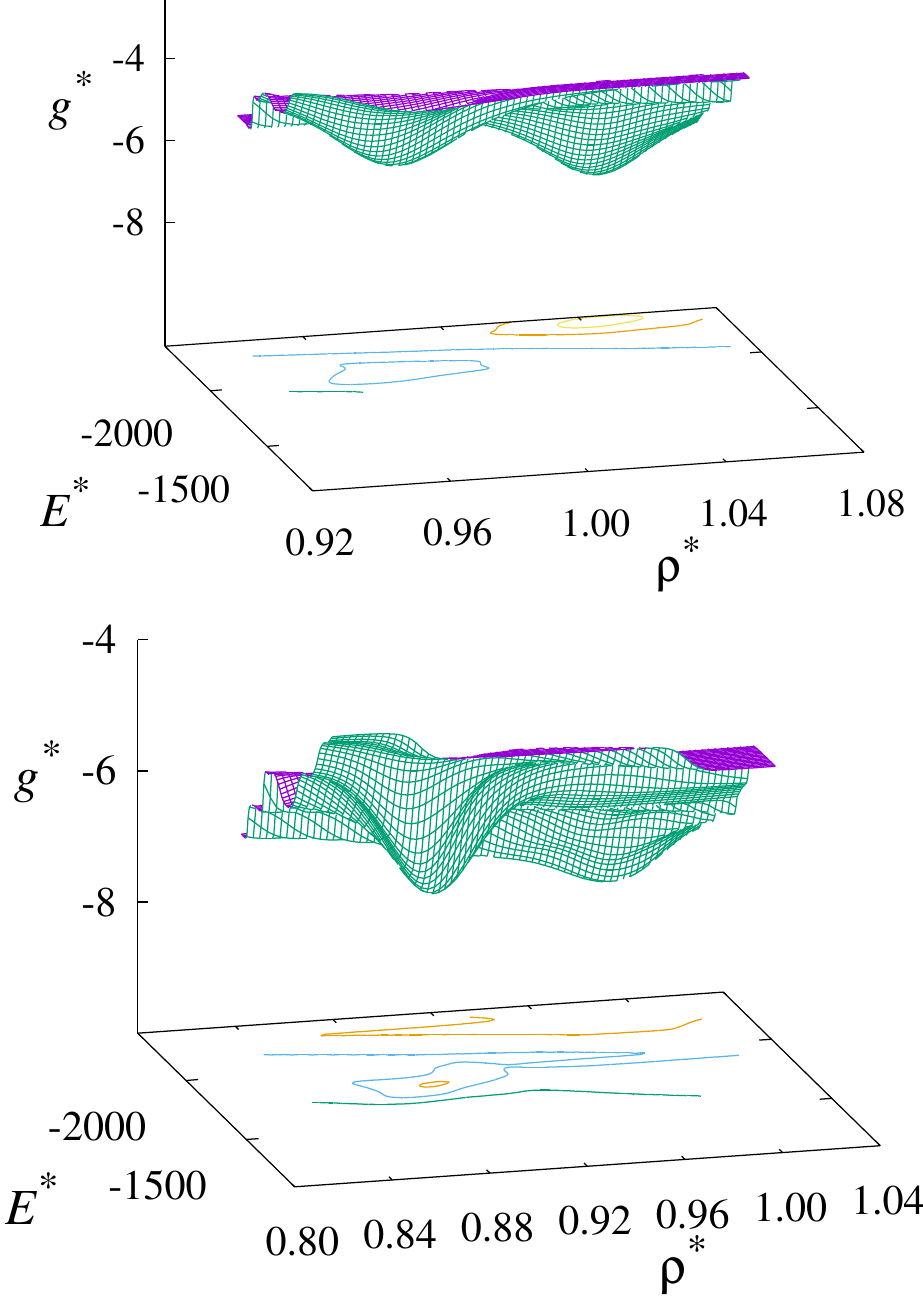
Figure 9. Plots of the free-energy surfaces for the nematic-solid phase transition for the upward ( top ) and downward ( bottom ) branches using replica-exchange MC at T ∗ =